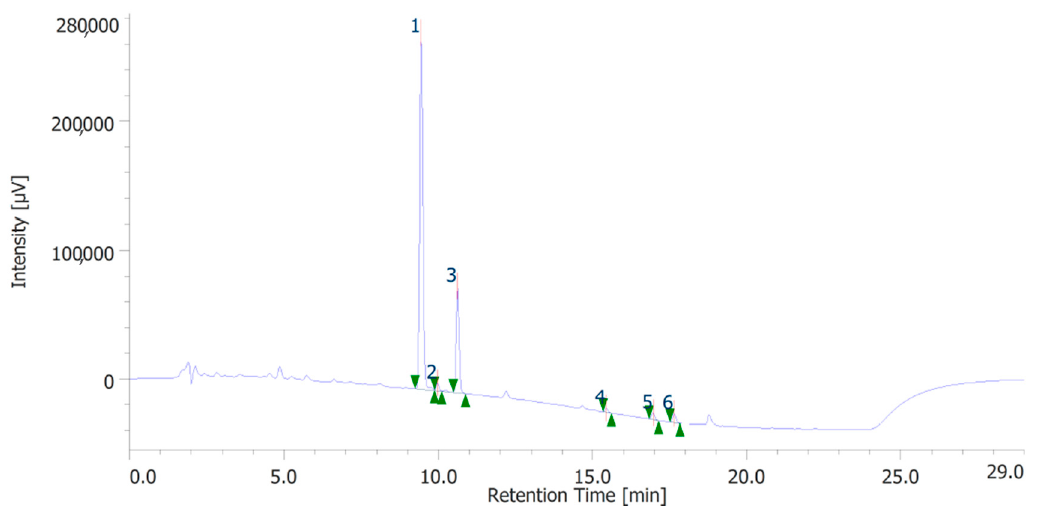
Figure 3. Terphenolic compounds identified in the hydroalcoholic extract of hemp inflorescences. Among the compounds quantitatively determined, cannabidiolic acid (peak #1: 45.99 μ g/mL) and cannabidiol (peak #3: 23.55 μ g/mL) were the most prominent.